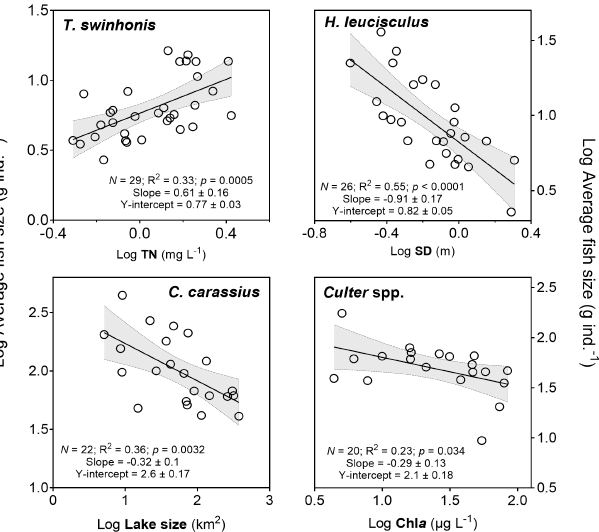
Figure 8. Relationship between average fish weight of the dominant fish species and the selected environmental variables. N , number of lakes; TN, total nitrogen concentration in the water; SD, depth; Chl a , chlorophyll- a concentration in phytoplankton. Toxabramis swinhonis (zooplanktivore), (piscivores). The dashed lines represent the 95% confidence